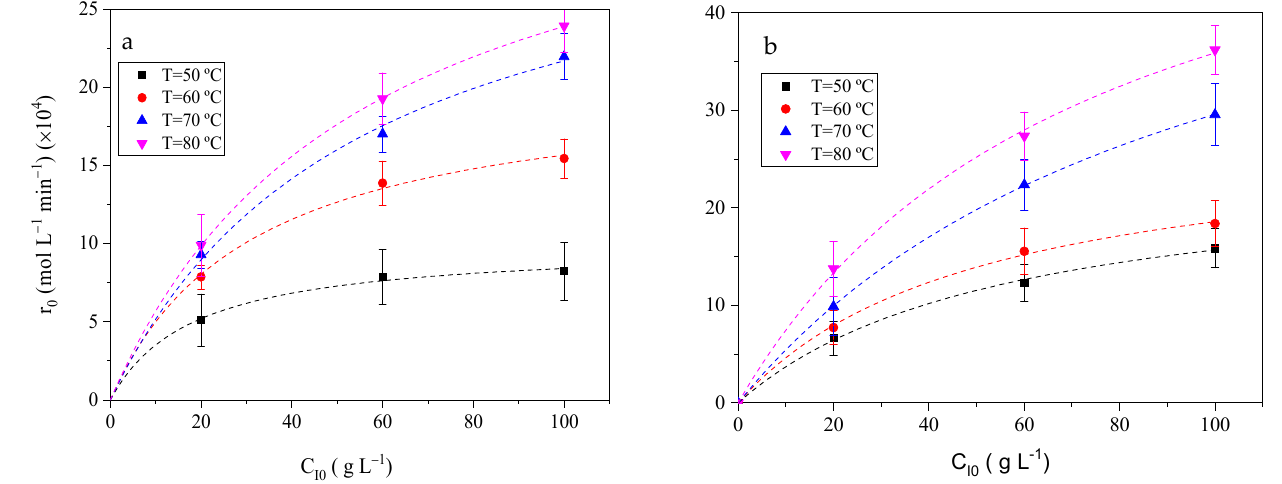
Figure 5. Effect of temperature on the initial rate of esterification for various initial concentrations of ibuprofen in a triphasic glycerol-toluene-N435 system with no added water ( a ) and with 7.4% v / v water at zero time (b) .